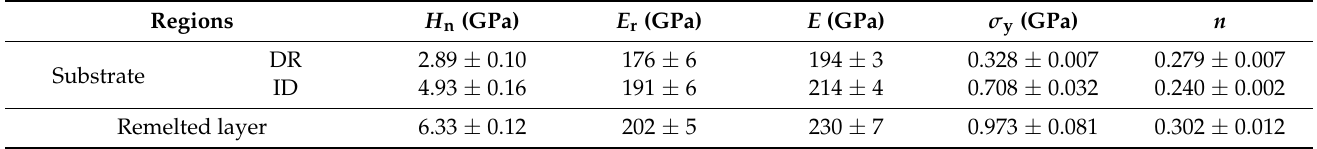
Table 2. Nanomechanical properties of the substrate and the remelted layer obtained from the nanoindentation